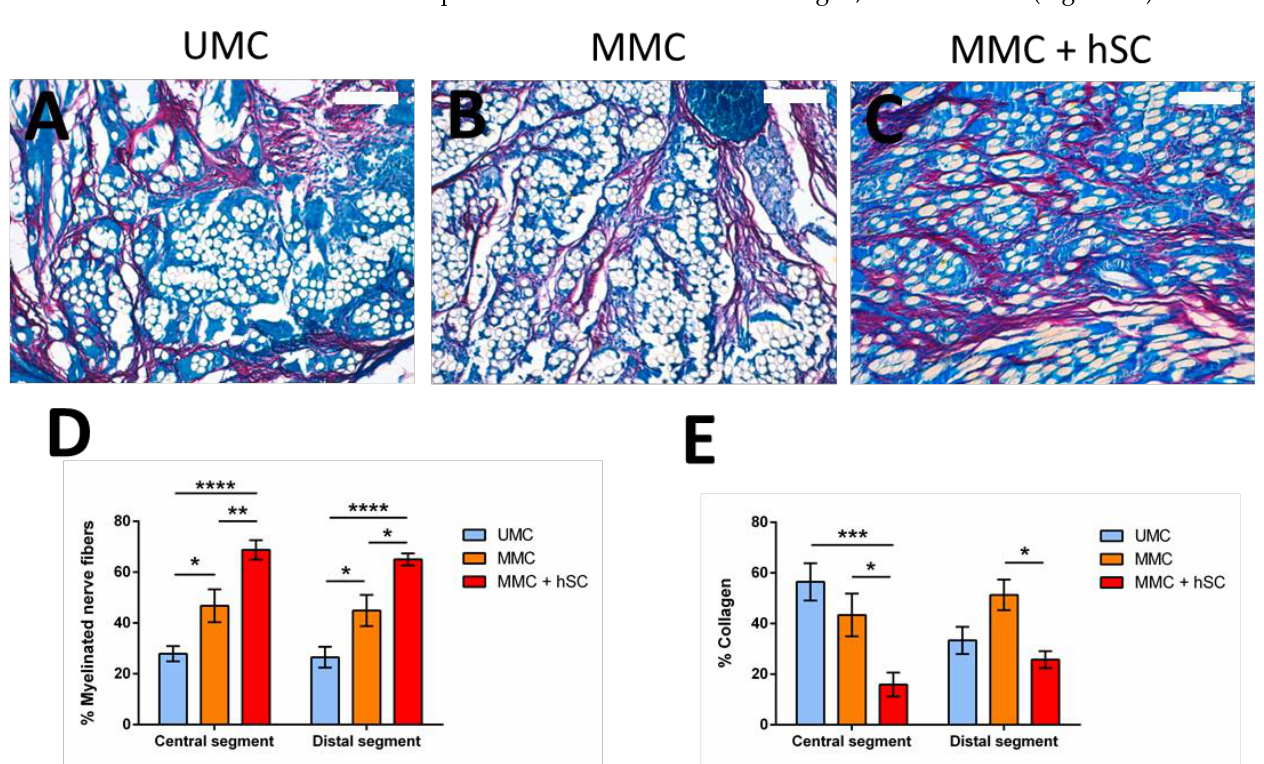
Figure 9. Luxol fast blue staining of tissue samples from the three experimental groups 6 months after surgery at the distal portion and quantification of the area of myelinated nerve fibers and collagen. ( A – C ) Luxol fast blue images of UMC, MMC and MMC + hSC, respectively, showing the collagen in red, the myelinated nerve fibers in dark blue, the macrophages/giant cells in light blue and the PLA/vessels/cavities in white. Magnification of 20×. Scale bar = 100 µm. ( D , E ) Quantification of the area occupied by myelinated nerve fibers and collagen, respectively, after excluding the area occupied by PLA microfibers, vessels and cavities. Statistically significant differences are indicated by *, **, *** or ****, indicating a p -value below 0.05, 0.01, 0.001 or 0.0001, respectively.